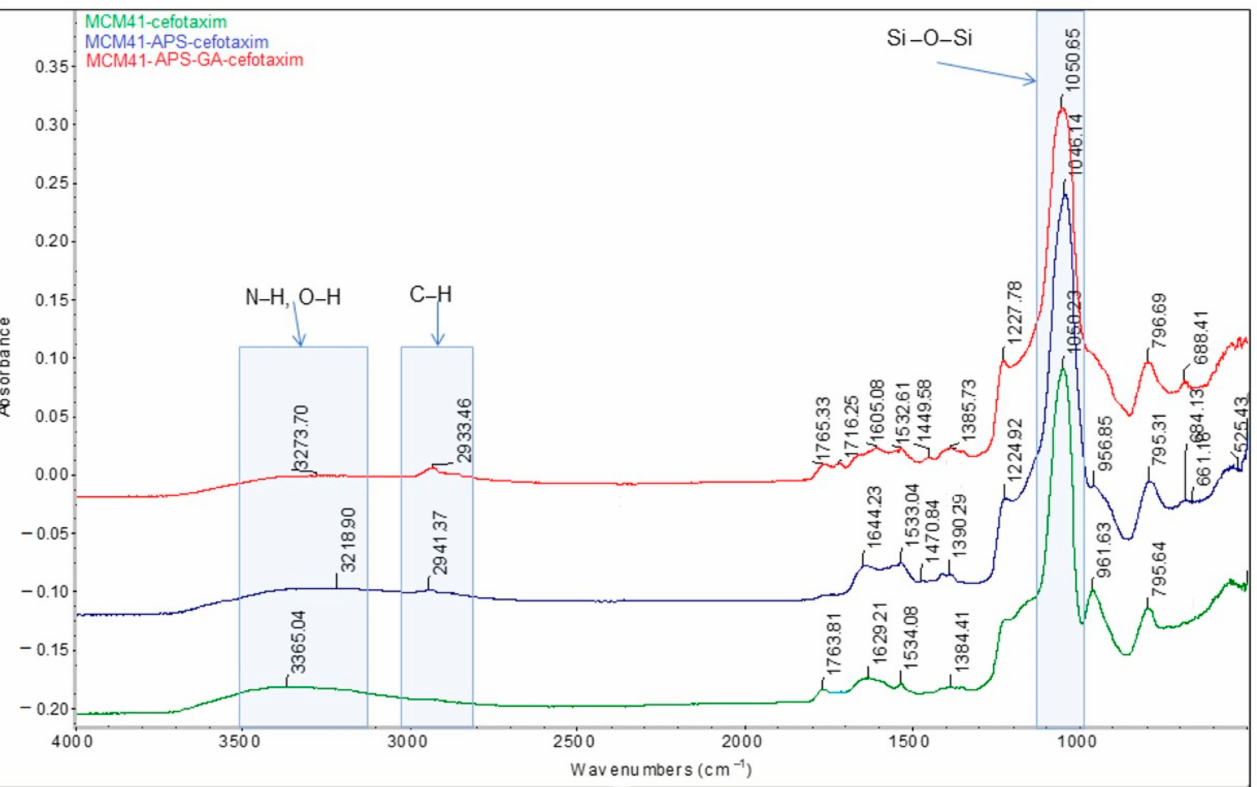
Figure 6. Comparative horizontal attenuated total reflectance (HATR)-FT-IR spectra of MCM-41/cefotaxime, MCM-41/APS—cefotaxime, and MCM-41/APS/GA—cefotaxime (the final 3 cefotaxime-loaded materials used for the desorption